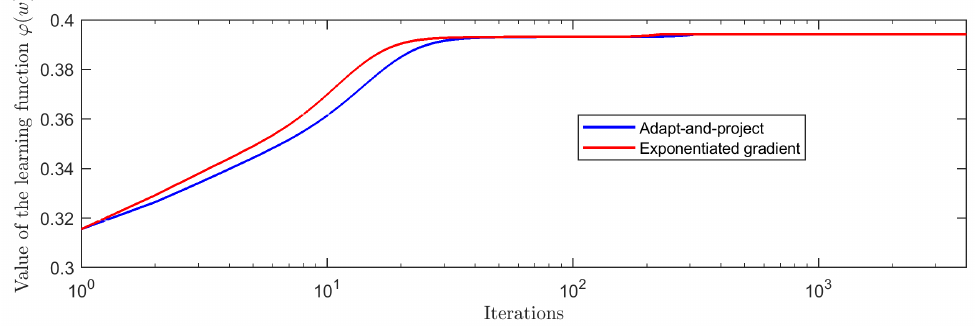
Figure 7. Learning curves of the exponentiated-gradient method and of the adapt-and-project method, superimposed (horizontal axis in logarithmic